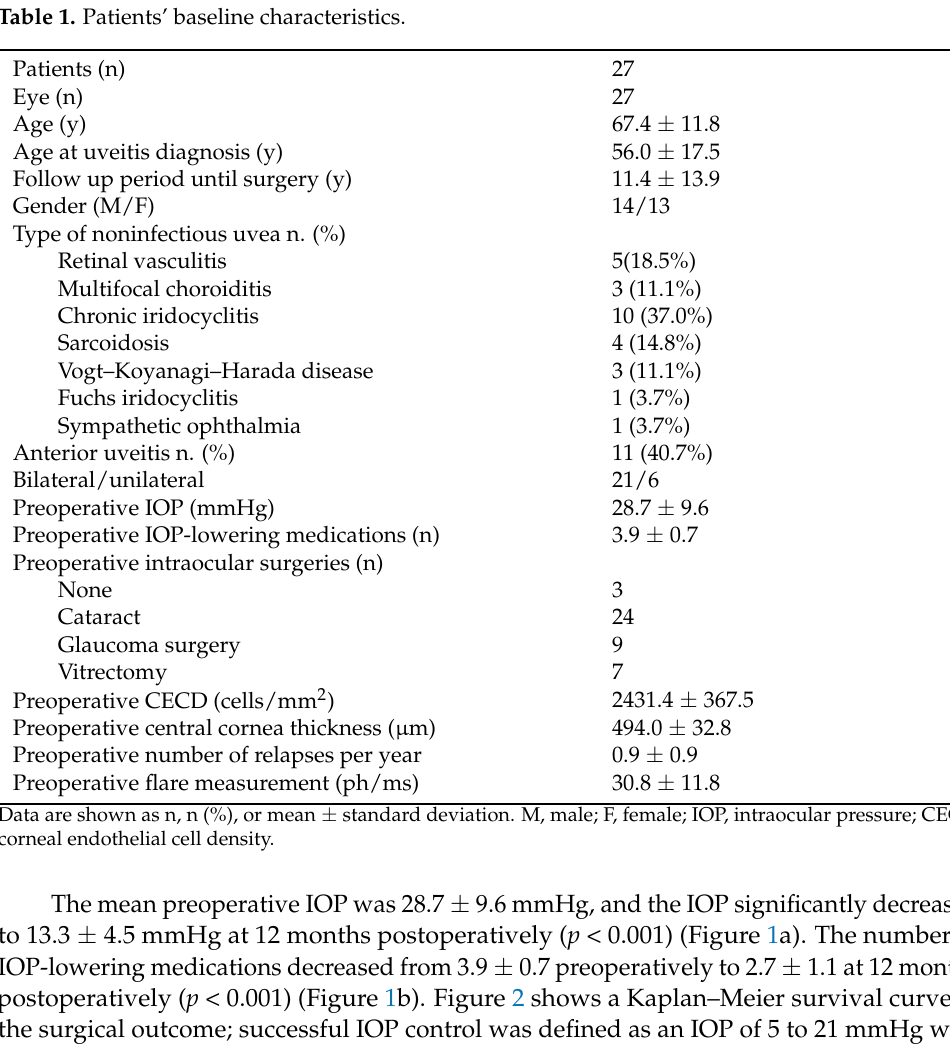
Figure 2. Kaplan–Meier survival curve of the surgical outcome. Table 2 shows the reduction in CECD after surgery. The mean CECD was 2431.4 ± 367.5 cells/mm 2 at preoperative baseline. The reduction rate at 6 and 12 months was 3.69 ± 13.67% and 2.73 ± 9.29%, respectively. The CECD was also measured in the contralateral eyes of patients with bilateral uveitis. Four patients who underwent AGV implantation in both eyes were excluded. Seventeen eyes were eligible for this analysis, two of which were not measurable because of bullous keratopathy. In the 15 remaining eyes, the mean de- crease in the CECD at 12 months was 24.3 ± 168.2 cells/mm 2 (reduction rate of 1.81 ± 8.39%). Table 2. Comparison of CECD in eyes treated by AGV implantation. Follow-Up Period